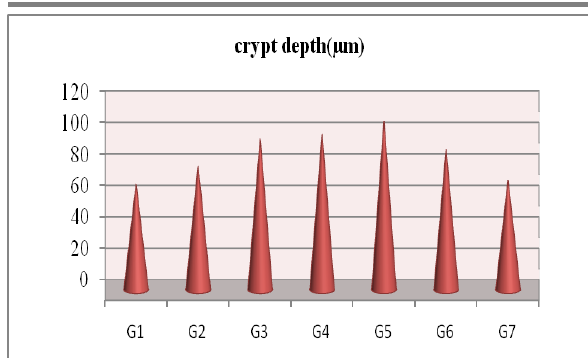
Figure 2. Effect of PLGANpsand PLGA loaded with different concentration of peptideon villus hight(µm). G1=received diH2O, G2= ordinary